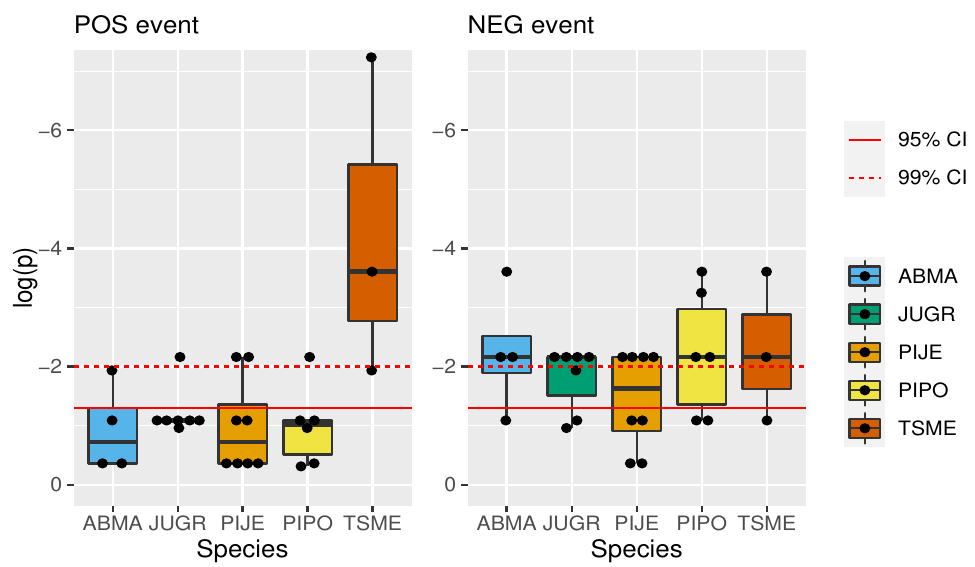
Figure 7. The significance of tracking of P12 whiplash events by single-site reconstructions. The y-axis is the p -value (log scale) representing the probability of obtaining the observed number of matches or greater by chance, according to the hypergeometric test. The species are color-coded. Each box plot summarizes the distribution of p -values for tracking chronologies of that species, and the dots, offset horizontally for clarity, give the p -values for individual chronologies. The median and middle quartile positive JUGR p -values are the same, so the box does not render.